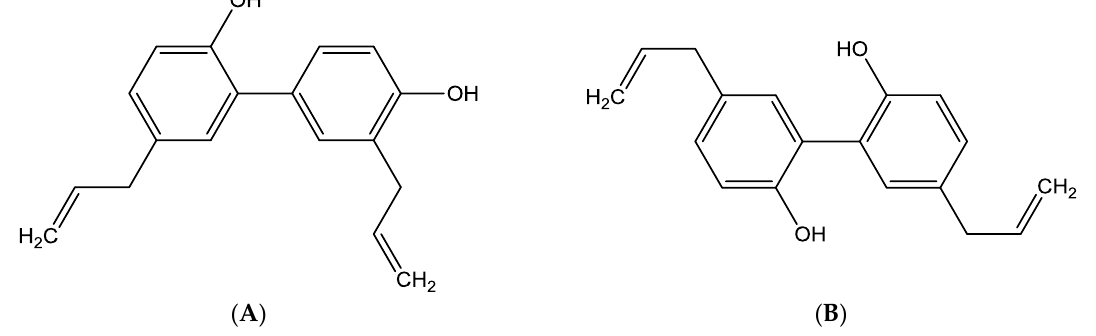
Figure 1. Chemical structures of honokiol ( A ) and magnolol ( B ).